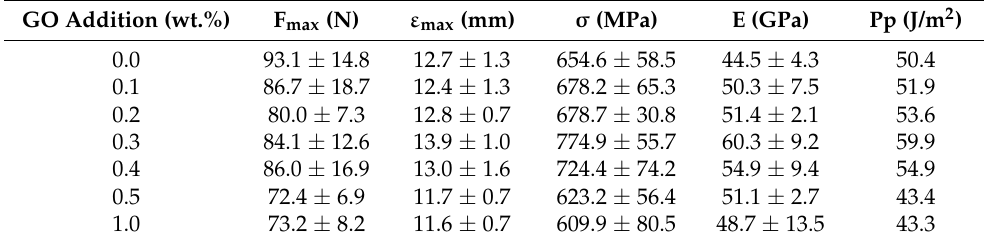
Table 2. Details of the quasi-static three-point bending